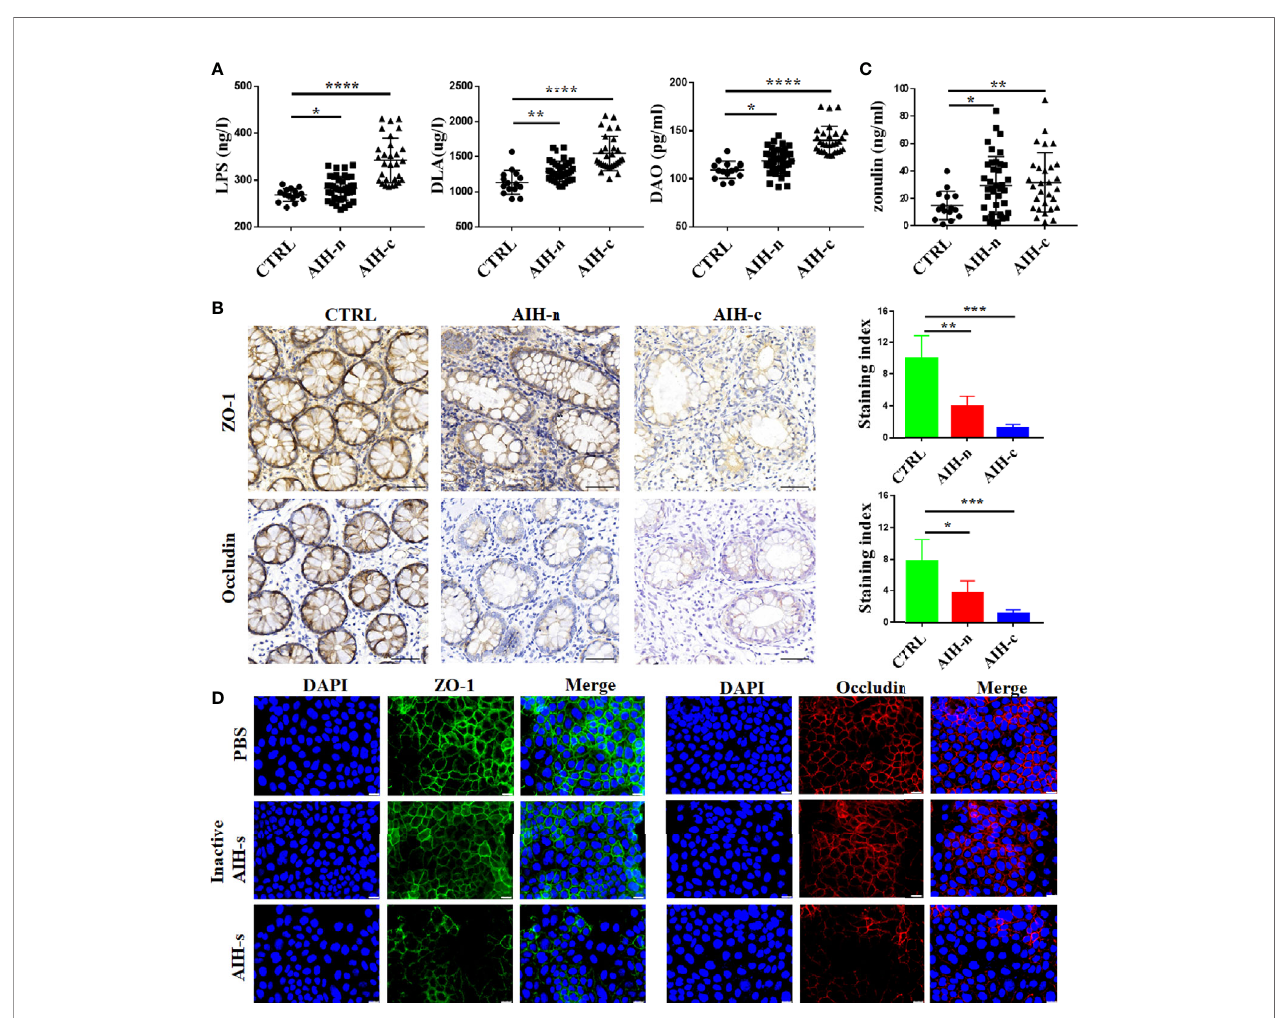
FIGURE 1 | Increased intestinal permeability and loss of epithelial barrier integrity in AIH patients. (A) The plasma concentrations of LPS, DLA and DAO in CTRL group (n=15), AIH-n group (n=39) and AIH-c group (n=29). (B) Expression of ZO-1 and Occludin in the colon were assessed by immunostaining. (C) The plasma concentration of zonulin in the three groups. (D) Representative immunostaining of ZO-1 and Occludin in Caco-2 cells. Scale bars: 50 m m. The data were presented as means ± SD (Student ’ s t-test, *p < 0.05, **p < 0.01, ***p < 0.001, ****p <